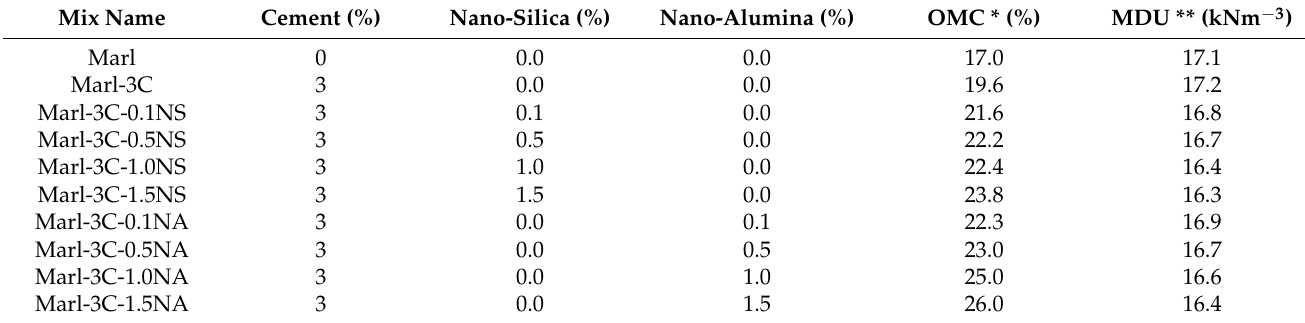
Table 4. Standard Proctor compaction properties of the nano-cement stabilized marl. Adapted from [72].